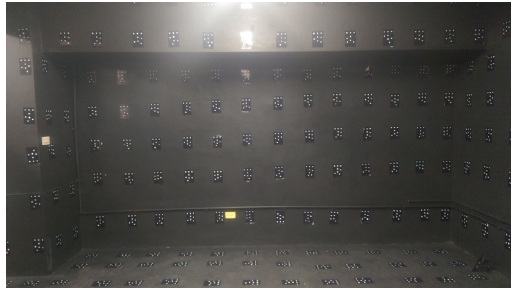
Figure 5. The professional camera calibration laboratory.